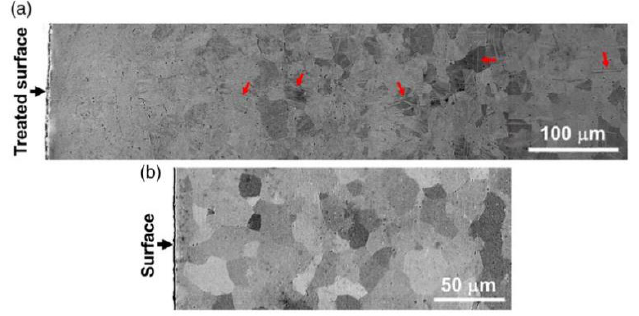
Figure 20. Cross-sectional scanning electron microscope (SEM) images of ( a ) gradient nanostructured surface (GNS) Ti samples and ( b ) coarse-grained (CG) Ti samples reprinted with permission from Ref. [17]. Copyright 2022,